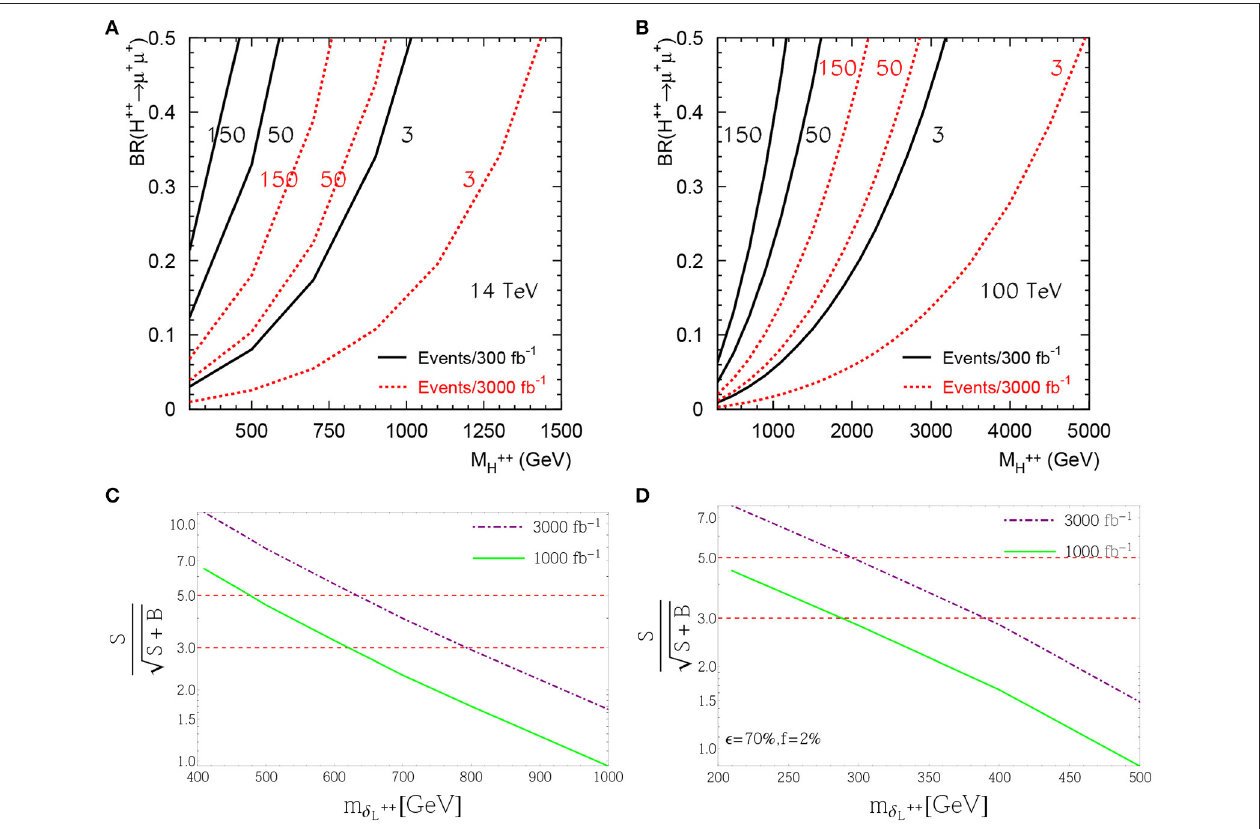
µ + µ + µ − µ − in the BR( H ++ → 1 and 3 ab − 1 at the 14 TeV LHC =